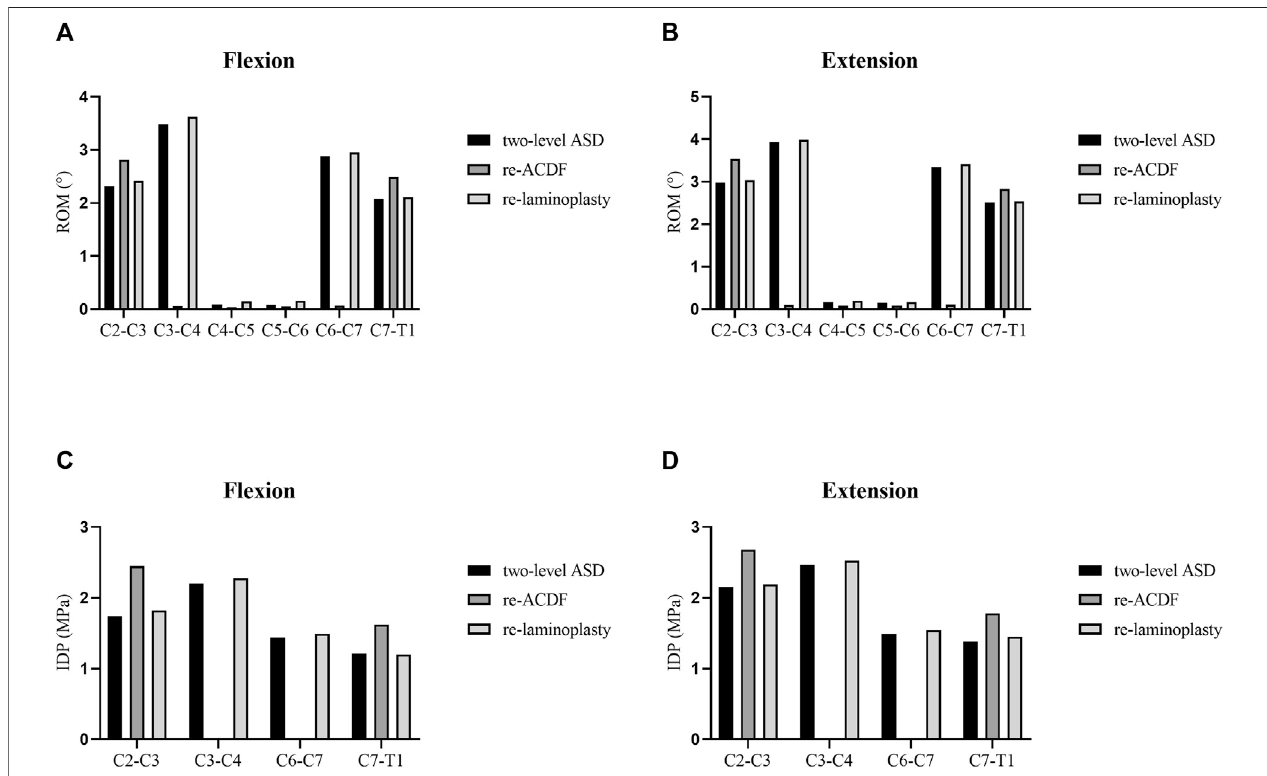
FIGURE 6 | ROM and IDP of different revision surgeries for the treatment of two-level ASD. (A) ROM in fl exion. (B) ROM in extension. (C) IDP in fl exion. (D) IDP in extension.